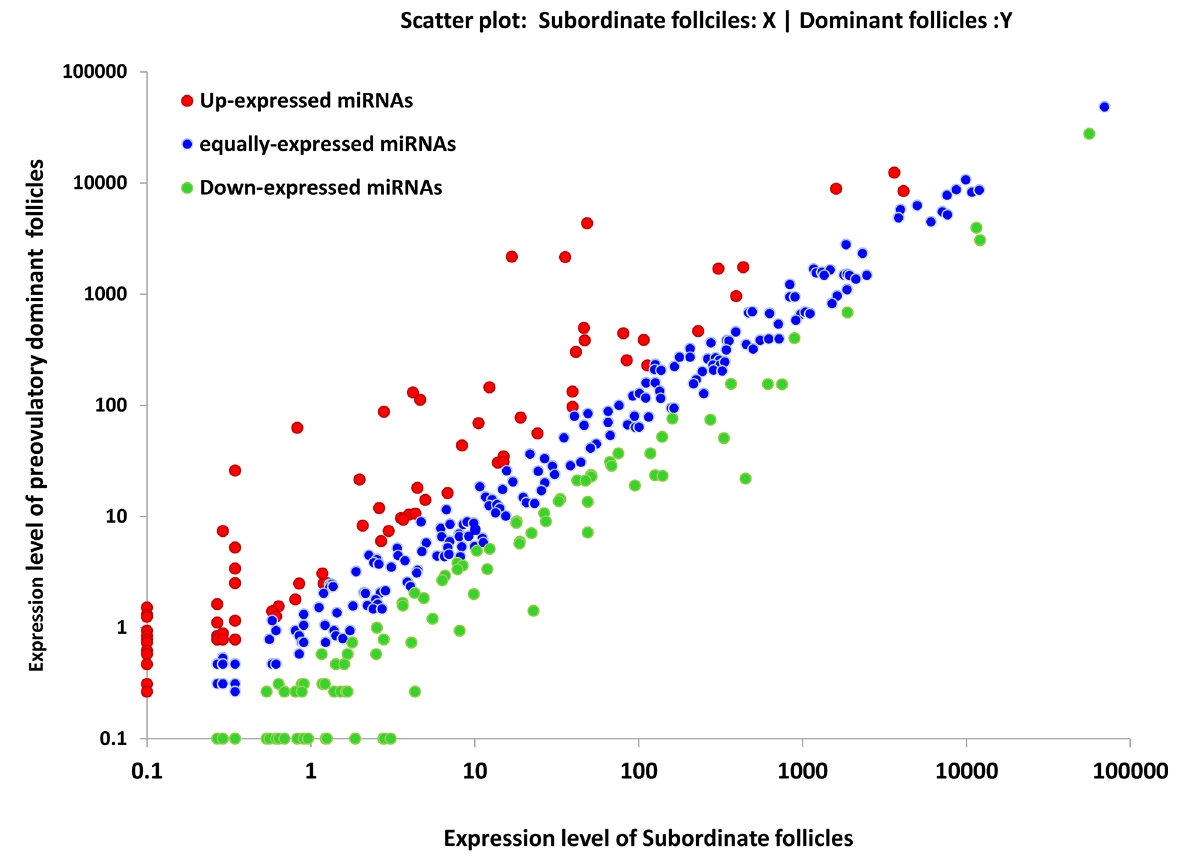
Fig 1. Scatter plot of miRNA expression level in preovulatory dominant and subordinate follicles. The expression level of preovulatory dominant and subordinate follicles is indicated in Y and X axis, respectively. Up-expressed miRNAs; with ratio (cid:3) 2 are labeled with red points. Equally expressed miRNAs; with 0.5 < ratio (cid:1) 2 are labeled with blue points. Down-expressed miRNAs; with ratio (cid:1) 0.5 are labeled with green points. Ratio = Normalized expression level in preovulatory dominant follicles / Normalized expression level in subordinate follicles